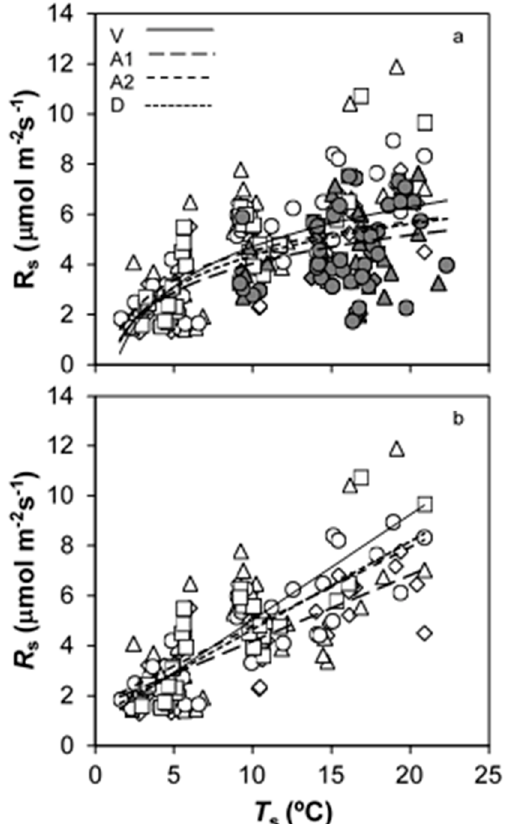
Figure 3. Soil respiration ( R s ) as a function of soil temperature ( T s ) throughout the entire study period ( a ) or after excluding observations above 15% soil water content ( b ); non-limiting SWC for R s ; see text), observed around centennial beech trees of different decline classes–vigorous (V; squares), affected (A1; diamonds), severely affected (A2; triangles), and dead (D; circles). Data points are mean values per plot and sampling campaign. In ( a ) open and closed symbols account for R s values above and below 15% SWC, respectively; non-linear models are fitted to all data points, separately among tree-decline classes. Modeled R s as a function of both T s and SWC exhibited a good agreement with observed R